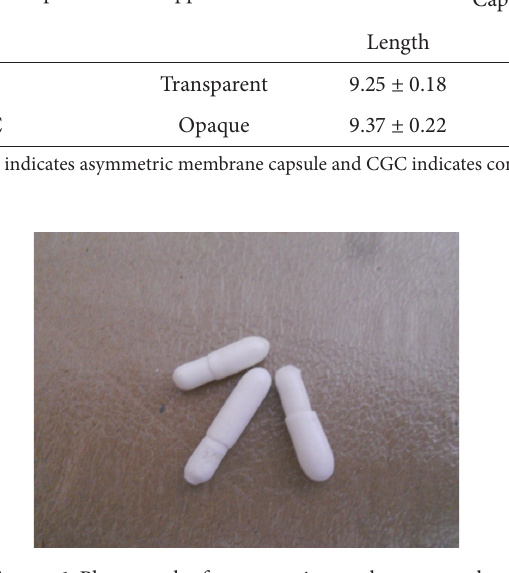
Figure 1: Photograph of asymmetric membrane